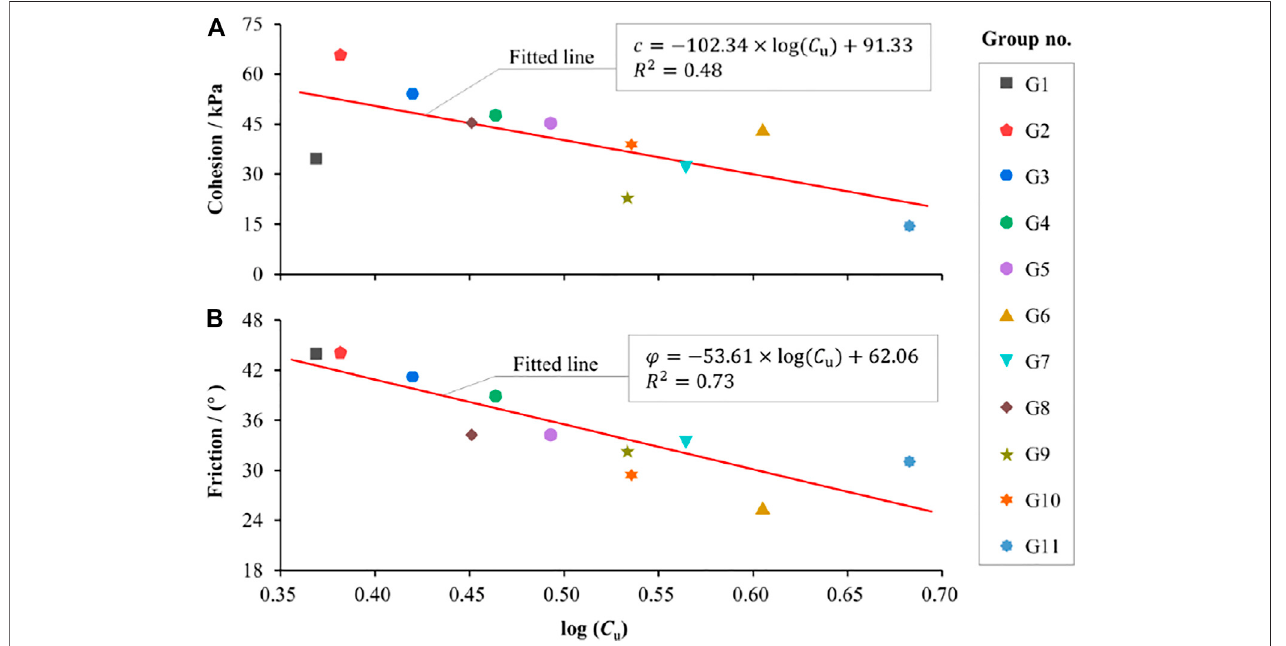
FIGURE16| Therelationshipbetweentheparticlecharacteristics ofTCSandthestrengthparameters:variationsofcohesion (A) andinternalfrictionangle (B) with the coef fi cient of uniformity of the particle gradation.